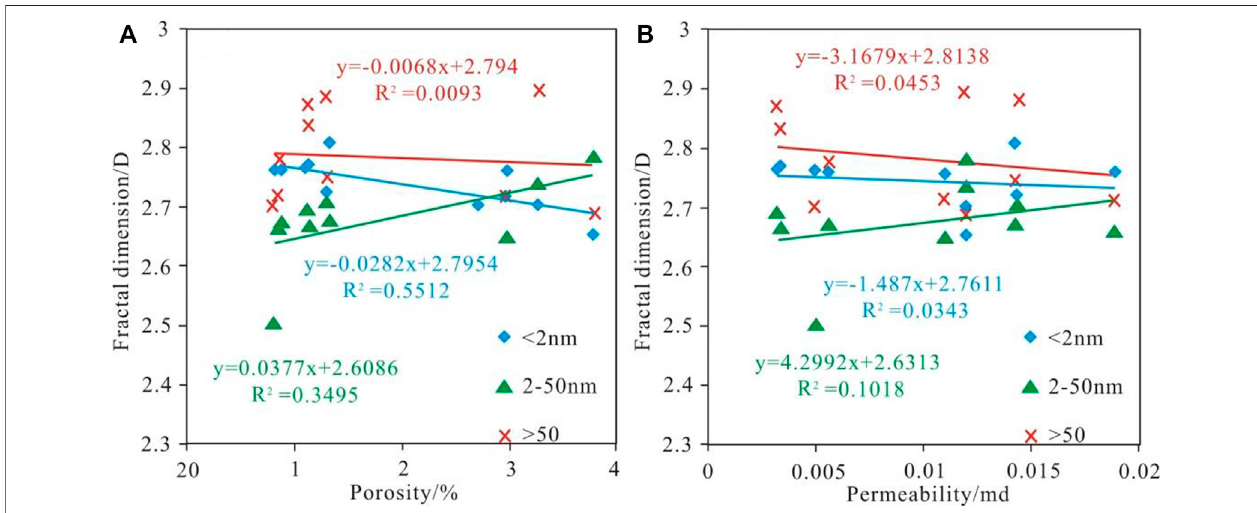
FIGURE 20 | Relationship of fractal dimension with porosity and permeability. Fractal dimension with (A) porosity, (B) permeability.